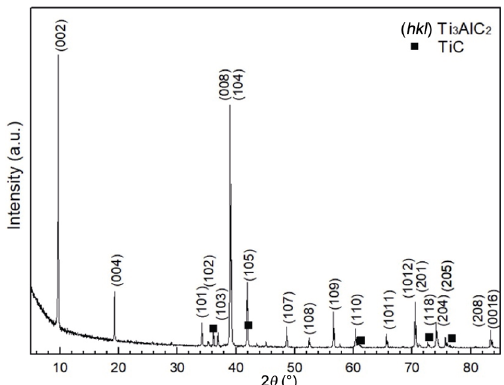
Fig. 1 XRD pattern of Ti 3 AlC 2 powders synthesized from TiC, Ti, and Al mixture at 1450 ℃ for 2 h in flowing Ar.